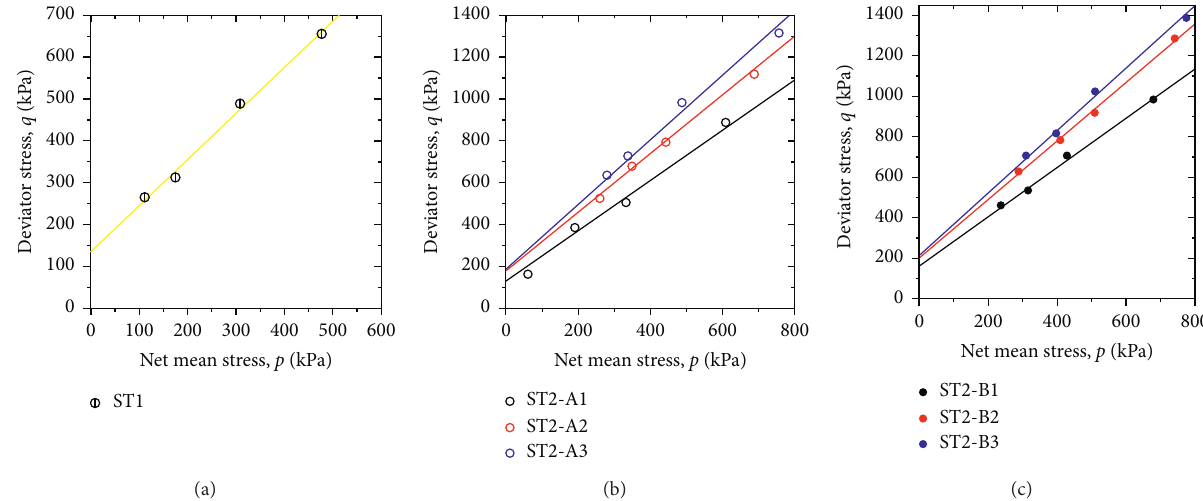
Figure 10: Critical state lines on q- p planes. (a) Undisturbed sample; (b) remoulded samples containing 3% nanosilica; (c) remoulded samples containing 5% nanosilica.